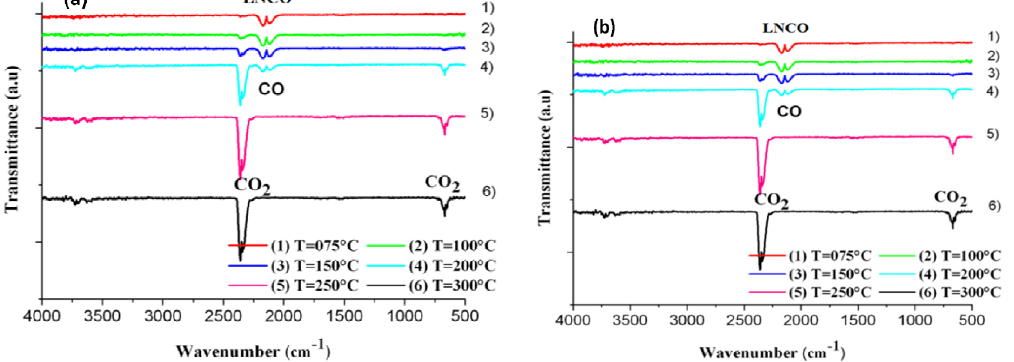
Figure 3. FTIR spectra analysis of the emitted gases under CO: ( a ) LNCO and ( b )